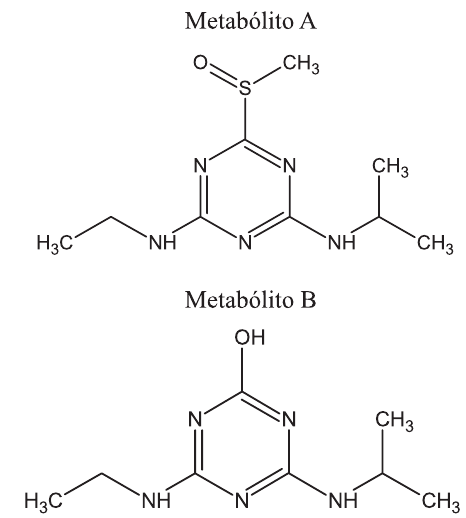
Figura 3. Fórmula molecular estrutural dos metabólitos n , n ’-bis(1-methylethyl)- 6-(methylsulfinyl)-1,3,5-triazine-2,4- diamine (metabólito a) e 4-(ethylamino)- 6-[(1-methylethyl)amino]-1,3,5-triazin-2-ol (metabólito B).